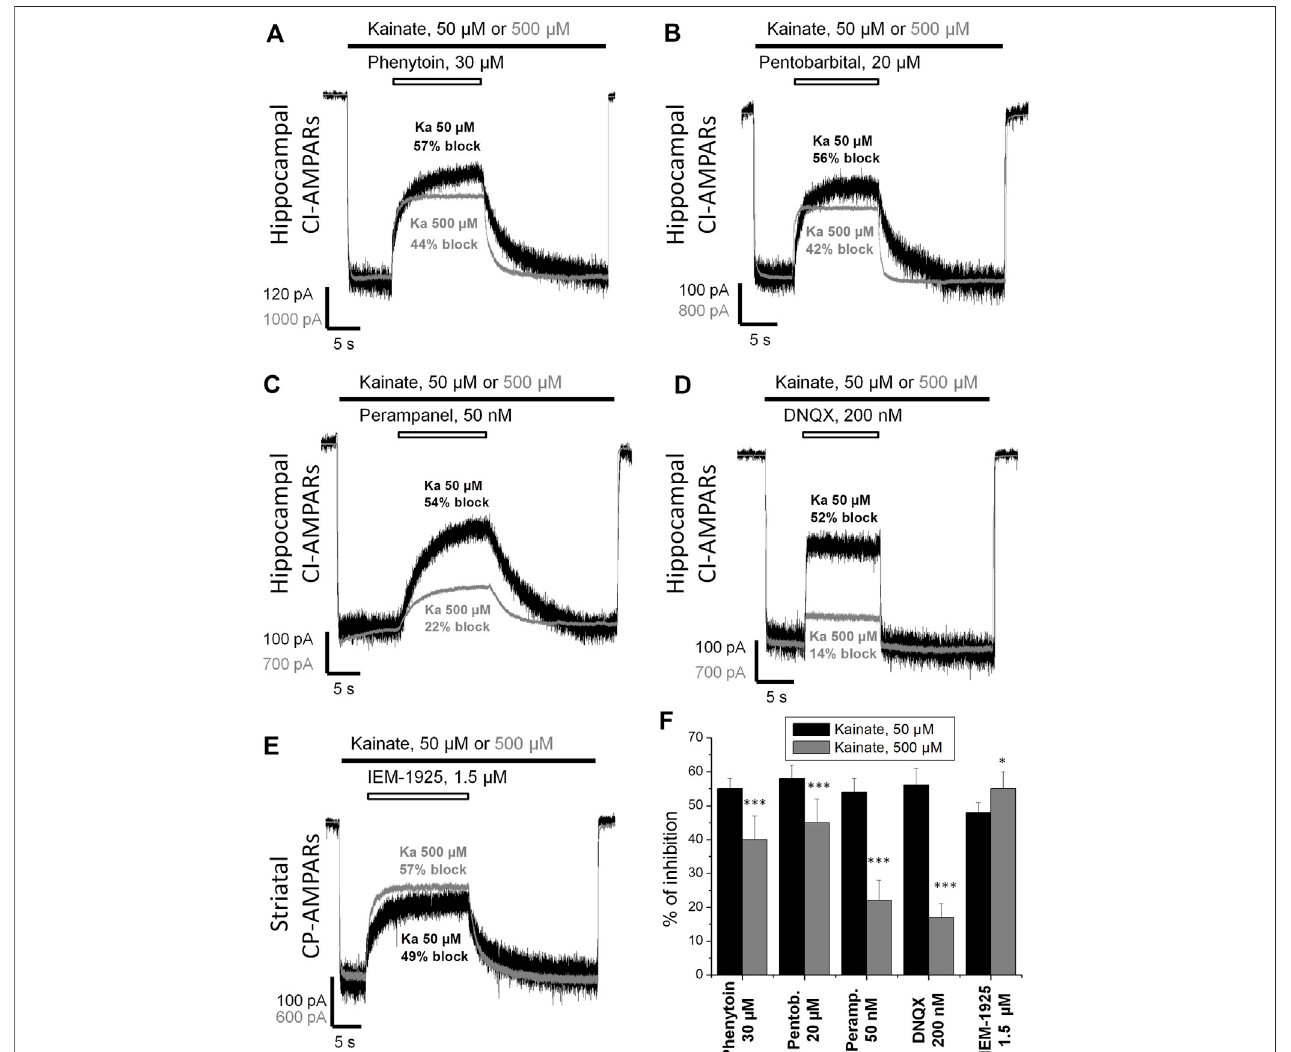
FIGURE 3 | Kainate concentration dependence of action of compounds on AMPA receptors. (A – E) Representative examples of CI-AMPARs inhibition by 30 µM phenytoin (A) , 20 µM pentobarbital (B) , 50 nM perampanel (C) , 200 nM DNQX (D) , and CP-AMPARs inhibition by 1.5 µM IEM-1925 (E) at 50 and 500 µM kainate concentrations. The amplitudes of responses at different kainate concentrations were normalized for visual clarity. (F) Summarized results of AMPARs inhibition by different compounds at 50 and 500 µM kainate concentrations. Phenytoin, pentobarbital, perampanel, and DNQX were more active in case of lower kainate concentration. In contrast, IEM-1925 was more active in case of higher kainate concentration. * – p < 0.05. *** – p < 0.001.